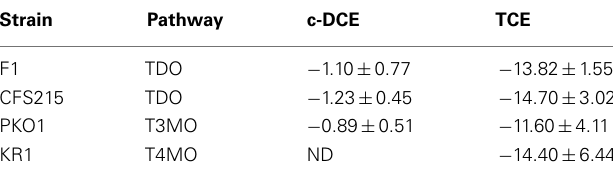
Table 2 | Enrichment factors ( ε ) expressed in ‰ ± 1 SD for δ 13 C from degradation of cis -1,2-dichloroethene (c-DCE) and trichloroethene (TCE) by four bacterial strains: Pseudomonas putida F1, P. fluorescens CFS215, P. mendocina KR1, and Ralstonia pickettii PKO1 containing three degradative pathways: toluene 2,3-dioxygenase (TDO),